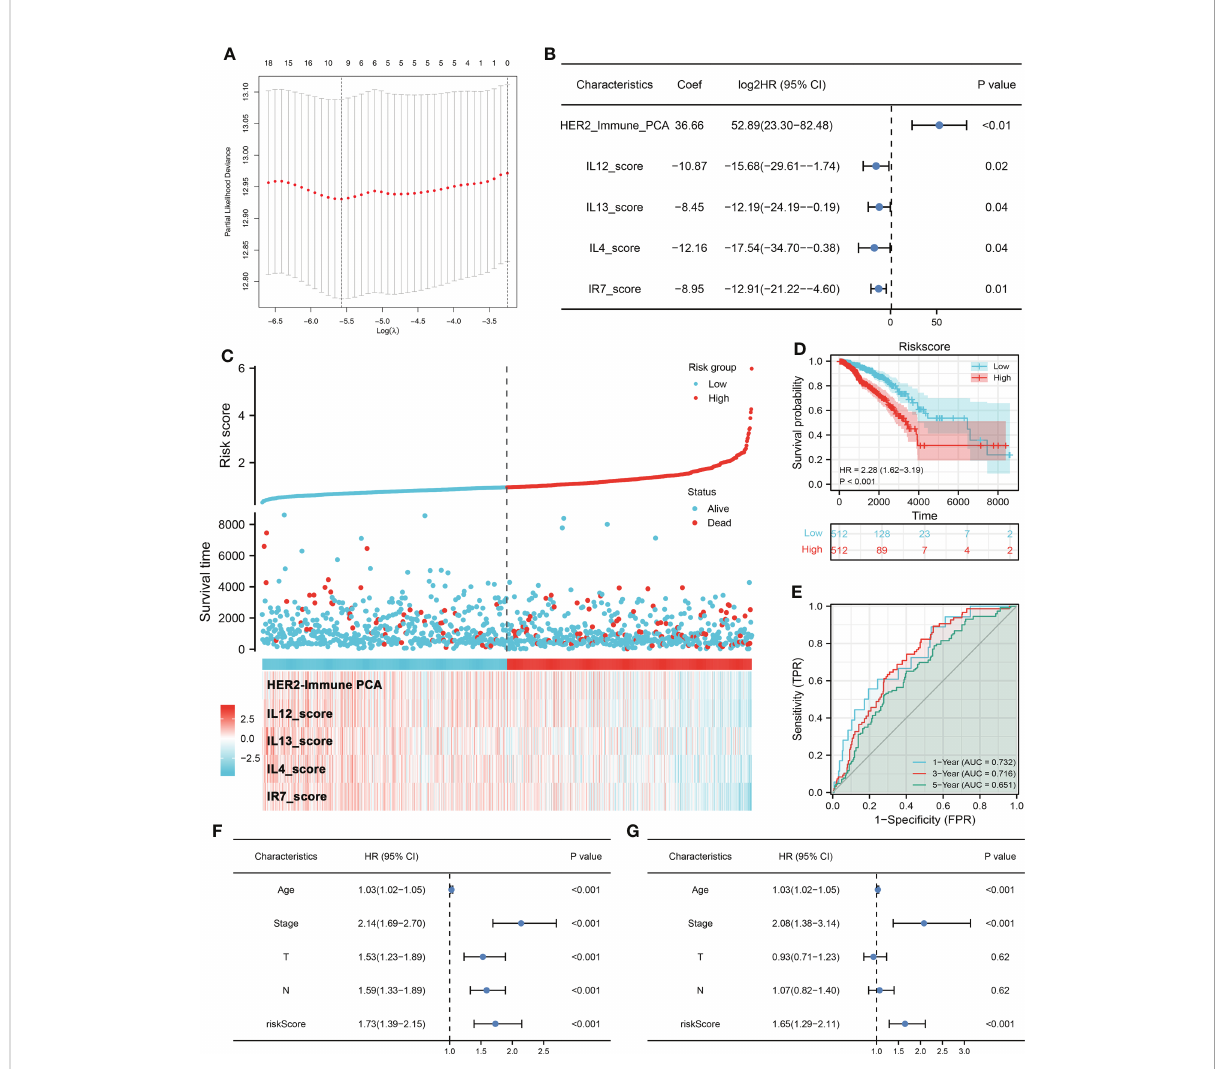
FIGURE 2 Prognosis model construction (A) LASSO regression was used for dimensionality reduction. (B) Multivariate Cox regression analysis was performed for model construction with the threshold of p -value < 0.05. (C) A prognosis model was fi nally established based on HER2_Immune_PCA, IL12_score, IL13_score, IL4_score, and IR7_score. (D) Kaplan – Meier survival curve showed that high-risk patients might have a worse prognosis. (E) ROC curve was used to evaluate the prediction ef fi ciency of our model. (F, G) Univariate and multivariate Cox analysis indicated that riskscore is a risk factor independent of other clinical